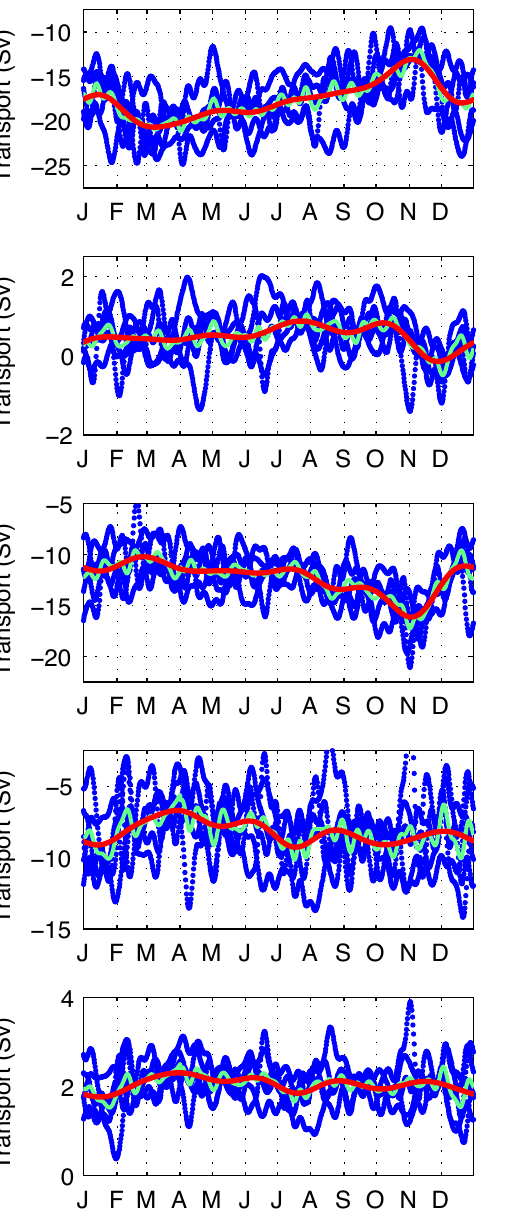
Fig. 8. Left column, seasonal transport cycles (red lines, as for Fig. 7) calculated in depth classes given in Table 3 for five years of Rapid- WATCH data (2004–2009). Blue lines denote each year of data overlaid (10-day low-pass filtered), fine green lines show the 5-year mean of each twice daily value (i.e., all 1 January’s, all 2 January’s etc.) which are then 60-day low-pass filtered to obtain the seasonal cycle (red lines). Right column, lines denote mid-ocean transport for the 6 hydrographic sections with (red) and without (blue) adjustment for seasonal anomalies (see also Table 5). Black bars denote the mean of the Rapid-WATCH data ± 2std. dev. of the de-trended and de-seasonalised 5-year timeseries. In addition to the ± 2std. dev. shown, hydrographic transport estimates will have a further uncertainty of order 0.1Sv associated with other sources of error (Sect.